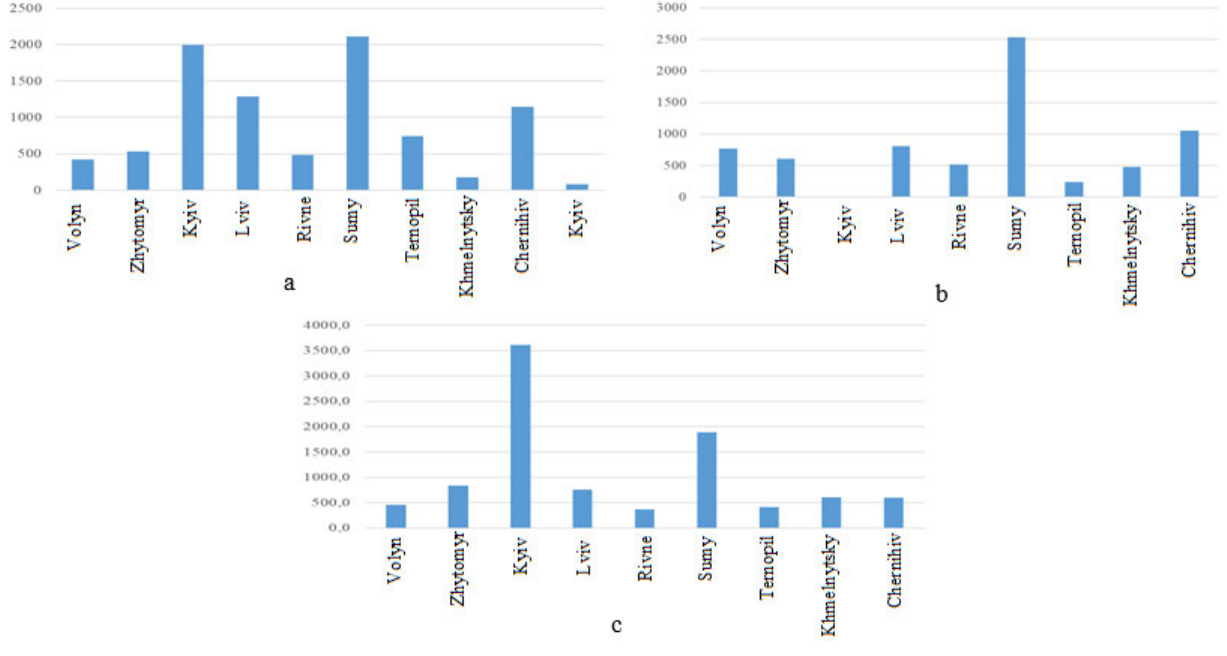
Fig. 2. Dynamics of catching aquatic organisms in inland waters,